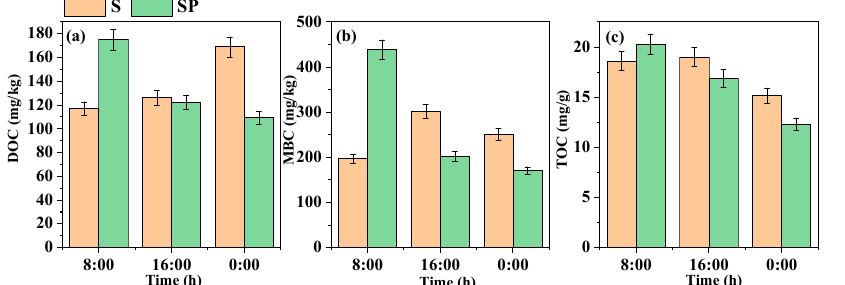
Figure 6. Diurnal variation of the TOC, DOC and MBC contents in the drainage ditch sediment. ( a ) DOC in sediment; ( b ) MBC in sediment; ( c ) TOC in sediment.